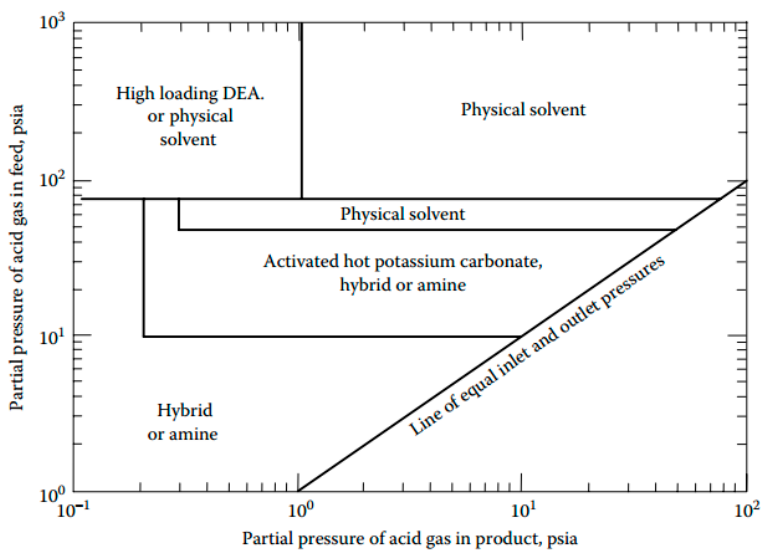
Figure 2. Process selection chart for simultaneous CO 2 and H 2 S removal [48].